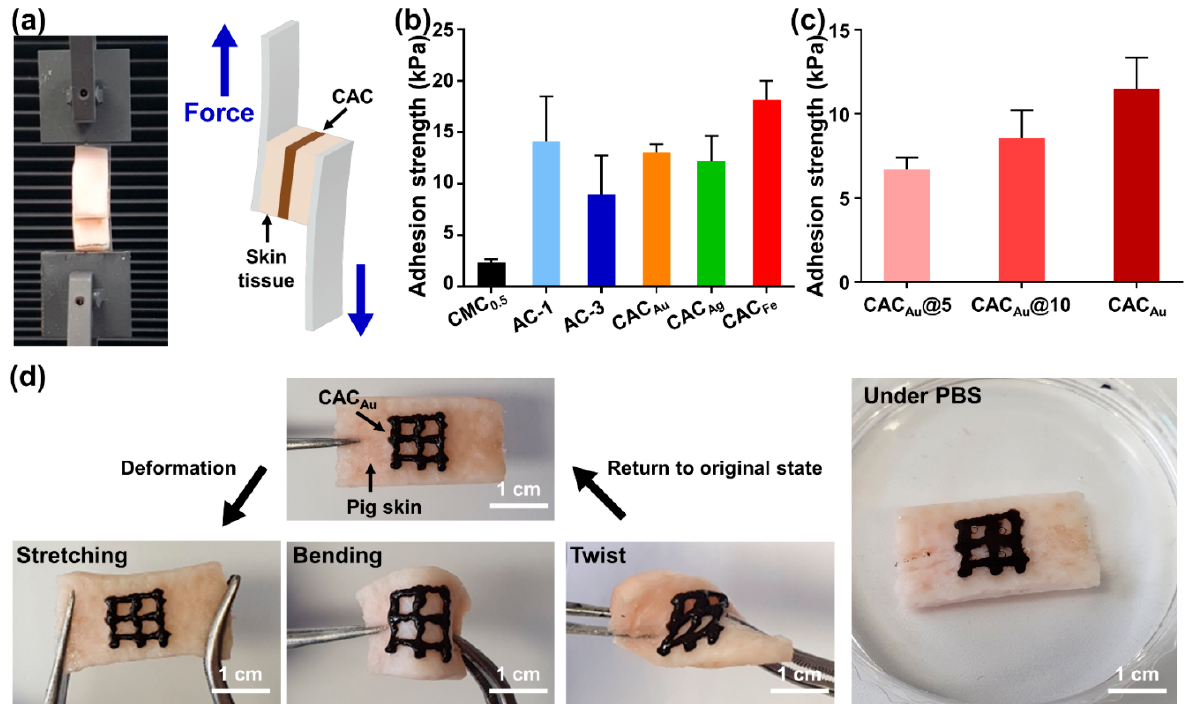
Figure 4. Tissue adhesion capabilities of CAC hydrogels. ( a ) Digital images and schematic of the shear adhesion test method using a UTM. ( b ) Evaluation of the shear adhesion strength of CMC0.5, AC-1, AC-3, CAC Au , CAC Ag , CAC Fe . ( c ) Evaluation of the shear adhesion strength of CAC Au depending on the amount of gold ions. ( d ) Macroscopic images of tissue adhesion in direct writing of CAC Au on tissue with various deformations of pig skin ( left ) and the stability in PBS ( right ).